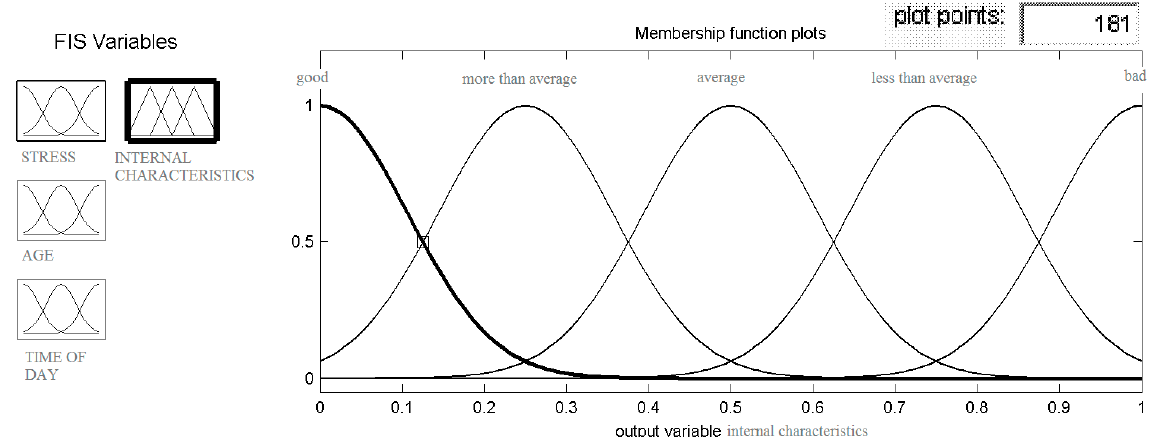
Figure 5. Membership function for internal characteristics .